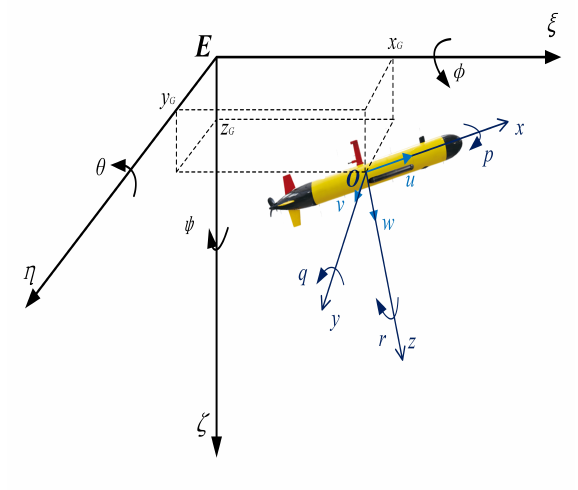
Figure 1. Coordinate system of